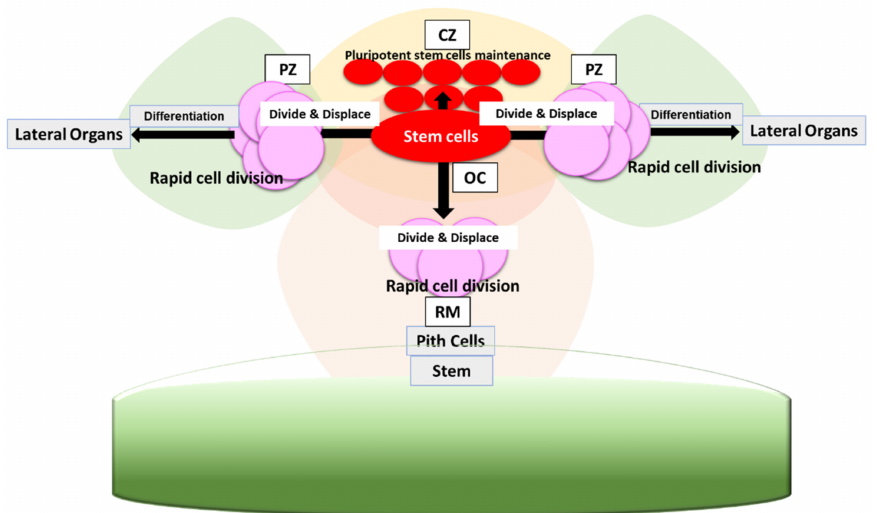
Figure 1. Stem cell organization in SAM. Stem cells present in the central zone (CZ) provides mainly two subsets of daughter cells. The one subset of cells rarely divides and maintains the stem cell pool. The other subset of cells rapidly divides and differentiates in peripheral zone (PZ) to give rise to lateral organs. Organizing center (OC) maintains stem cell population. Cells that are displaced basally to the rib meristem (RM) give rise to pith cells, eventually forming